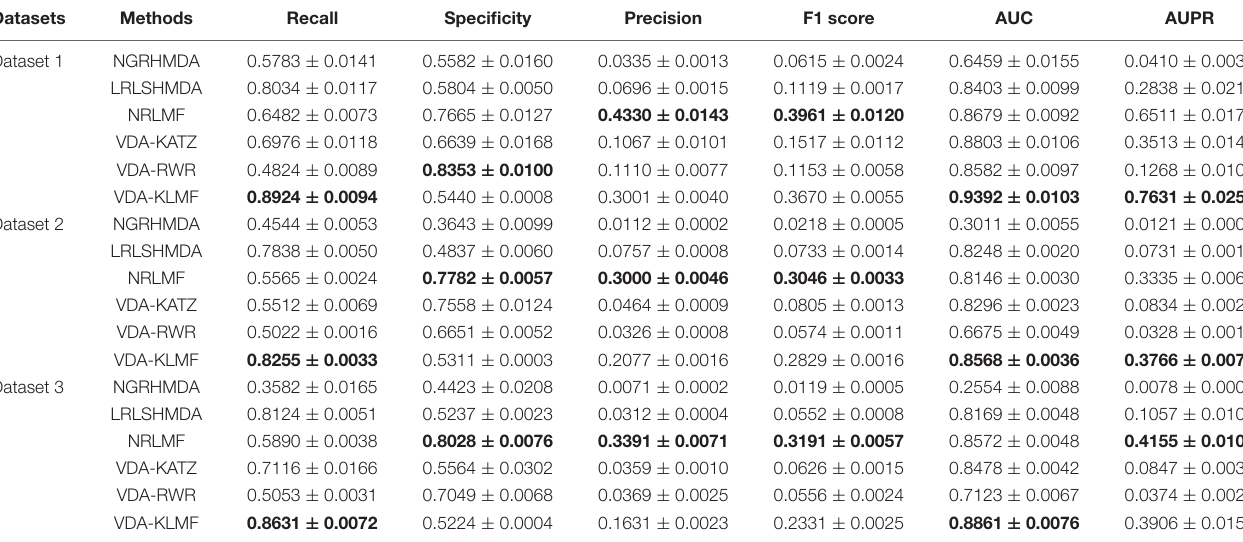
TABLE 5 | The performance of six VDA prediction methods on three datasets under